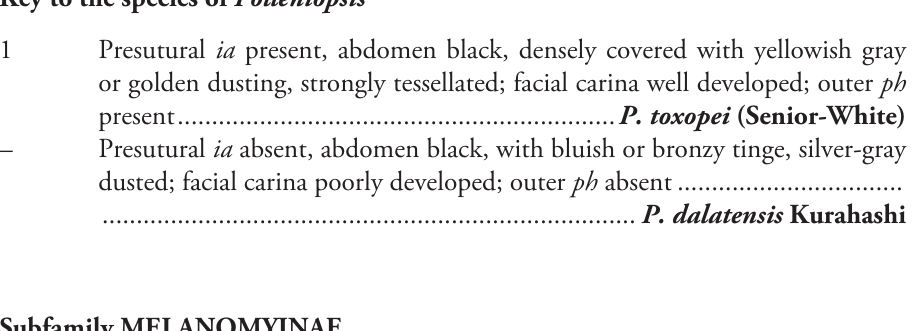
Presutural ia present, abdomen black, densely covered with yellowish gray or golden dusting, strongly tessellated; facial carina well developed; outer ph Presutural ia absent, abdomen black, with bluish or bronzy tinge, silver-gray